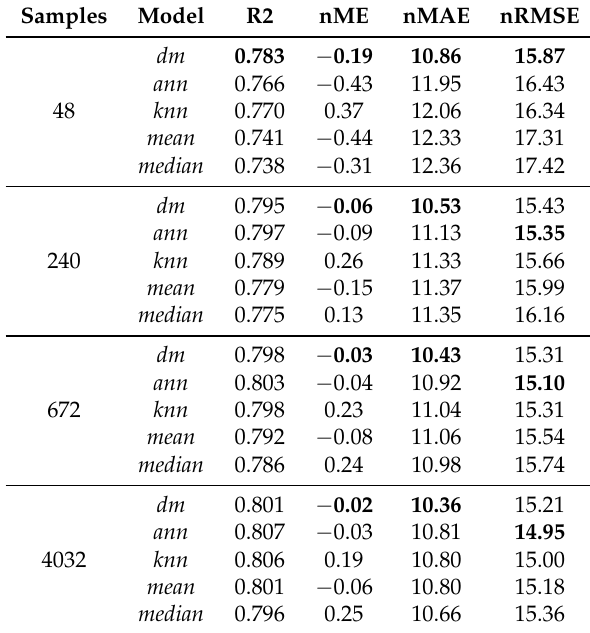
Table 1. Error measures of the forecasting models with different training set samples size, for turbine 1. The number of samples correspond to 2 days, 10 days, 4 weeks and 24 weeks of data.